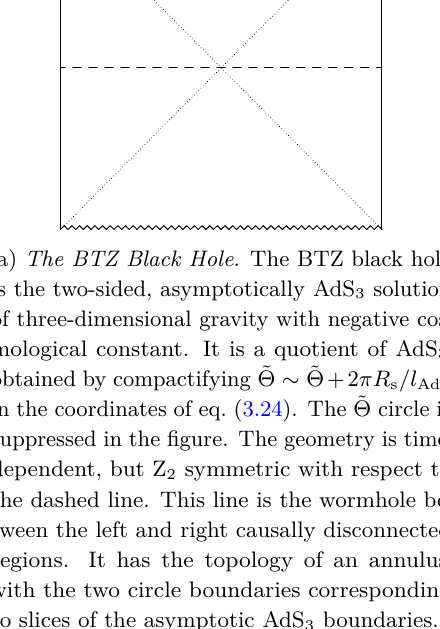
Figure 15 . The Lorentzian and Euclidean BTZ Black